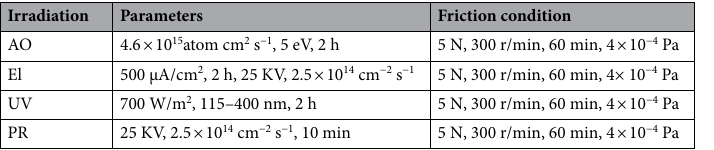
Table 1. Experimental parameters of the simulated space irradiation and friction